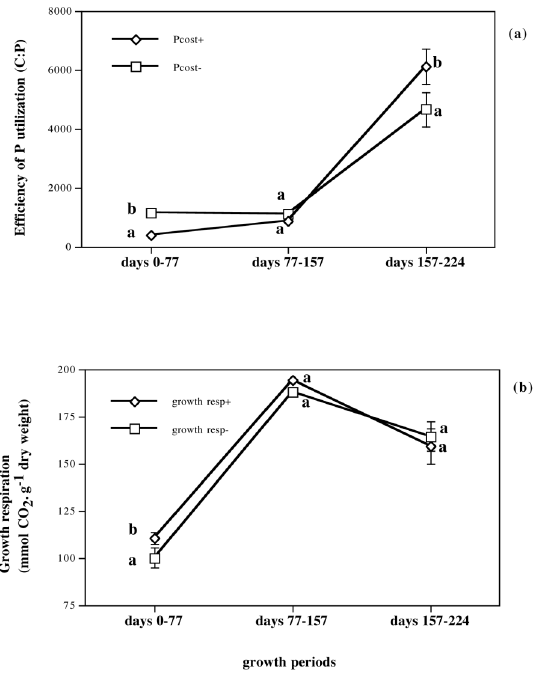
Fig. 5 . (a) Efficiency of P utilization (C:P), and (b) growth respi- ration (mmol CO g DW –1 ) of Agathosma betulina colonized by 2 arbuscular mycorrhizal (AM) fungi. Differences between AM in- oculated (+AM) and non-AM (–AM) plants were determined by t-test for independent samples by groups. Statistically significant differences (p £ 0.05) between AM inoculated and non-AM plants for each growth period are indicated by different letters. Error bars represent mean ± SE (n =